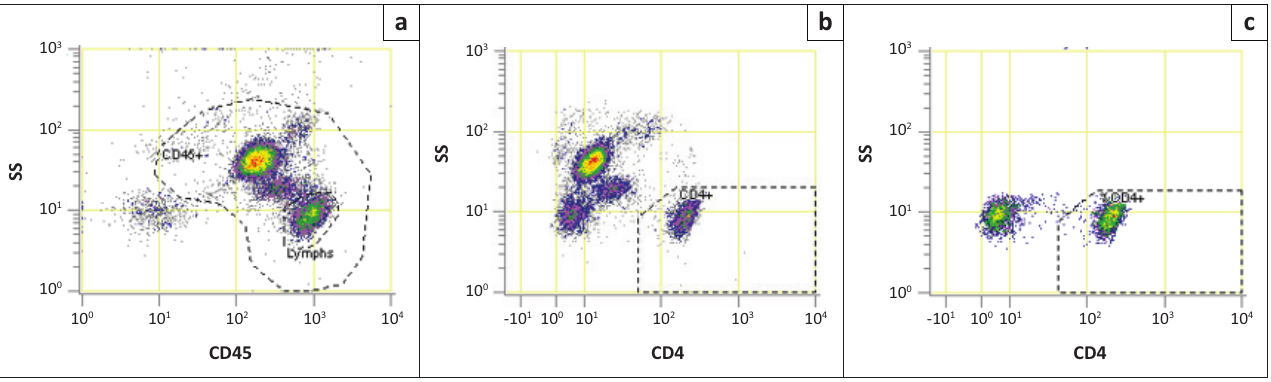
FIG URE 1: CD4 T-cell enumeration by Panleucogating with AQUIOS Flow cytometer, Canada; Paris, France; Lyon, France; and South Africa, November 2014 to March 2015. (a) CD45 versus side scatter plot is used to identify total leukocytes (CD45-positive); (b) All events gated in the CD45-positive region (Pan-Leucogate) are used to plot CD4 versus side scatter to identify CD4-positive lymph cells (CD4-positive Count/μL). (c) Lymphs gate from A is used to plot the CD4 versus side scatter to calculate the CD4 percentage of lymphoid cells (CD4-positive Lymph